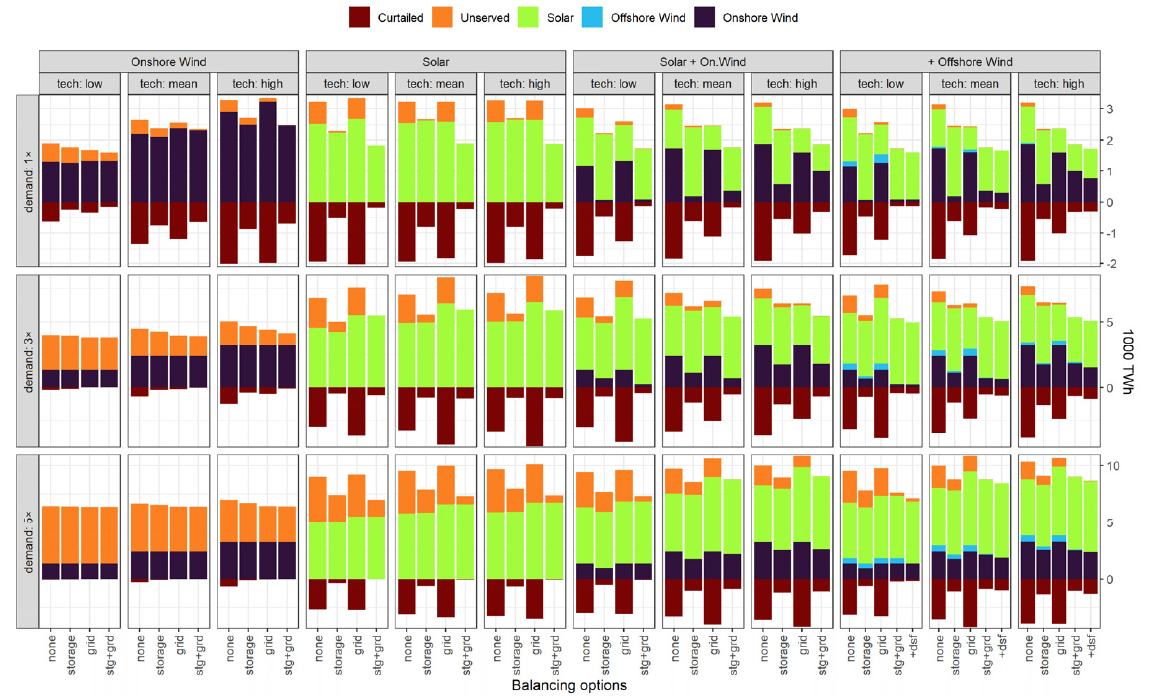
Figure 6. Electric power generation structure by technology, curtailed supply, and unmet load in 153 scenarios.